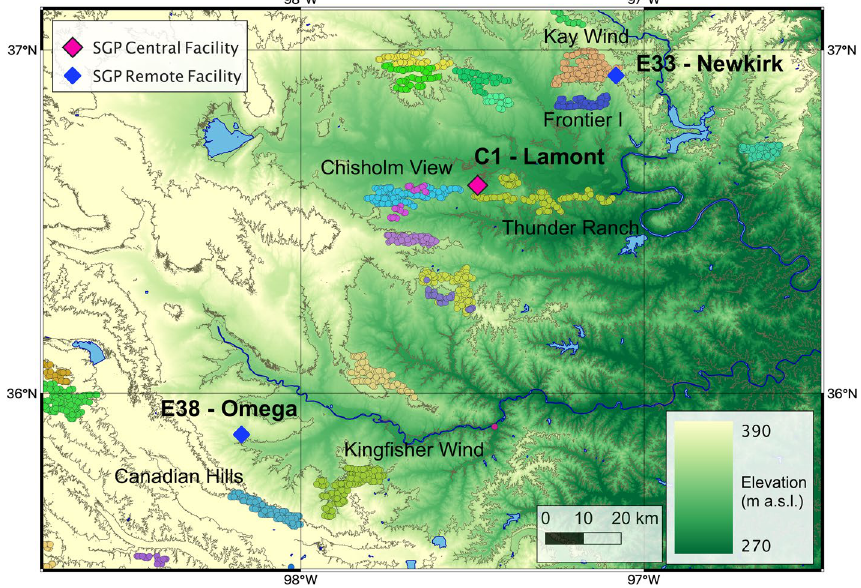
Figure 1. Map of the region and the three measurement sites whose observations are considered in the analysis. The clusters of differently colored dots show wind plants in the region. The named wind plants are those listed in Table 1 and relevant to this analysis. Map created by the authors using the QGIS v3.10.14 open-source software (qgis.org). Digital elevation model data courtesy of the US Geological